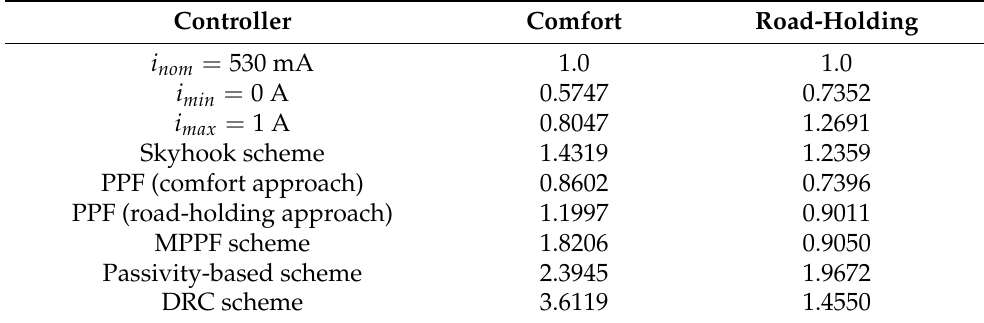
Table 4. Normalized performance criteria comparison for different damping control and variable sprung